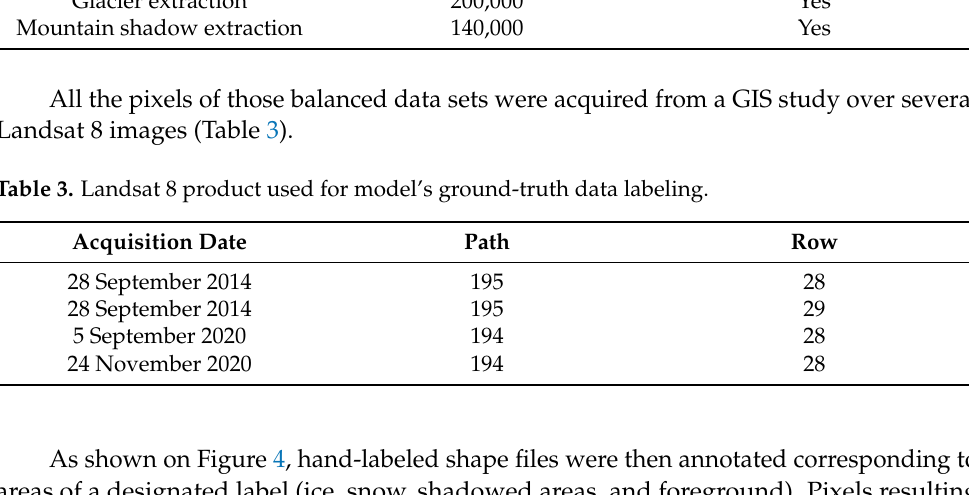
Table 2. Different data sets used in this article. Around 600,000 pixels were labeled. Detection Task Size (in Pixels) Expert Verification Ice and snow extraction 270,000 Yes Glacier extraction